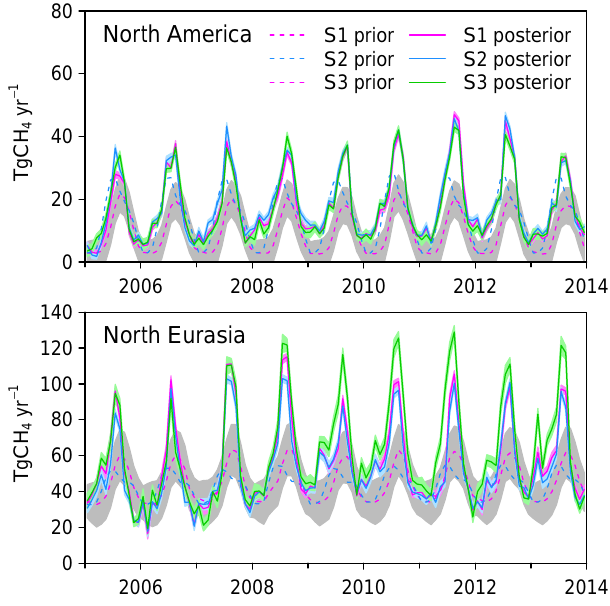
Figure 10. Area-integrated CH 4 fluxes (units TgCH 4 yr − 1 ) from the three scenarios shown monthly for northern North America and northern Eurasia. The prior fluxes are shown by the dashed lines and the posterior fluxes by the solid lines (note that the prior fluxes used in scenarios S1 and S3 are the same). The grey shading indicates the prior uncertainty (shown only for the S1 prior) and the coloured shading indicates the posterior